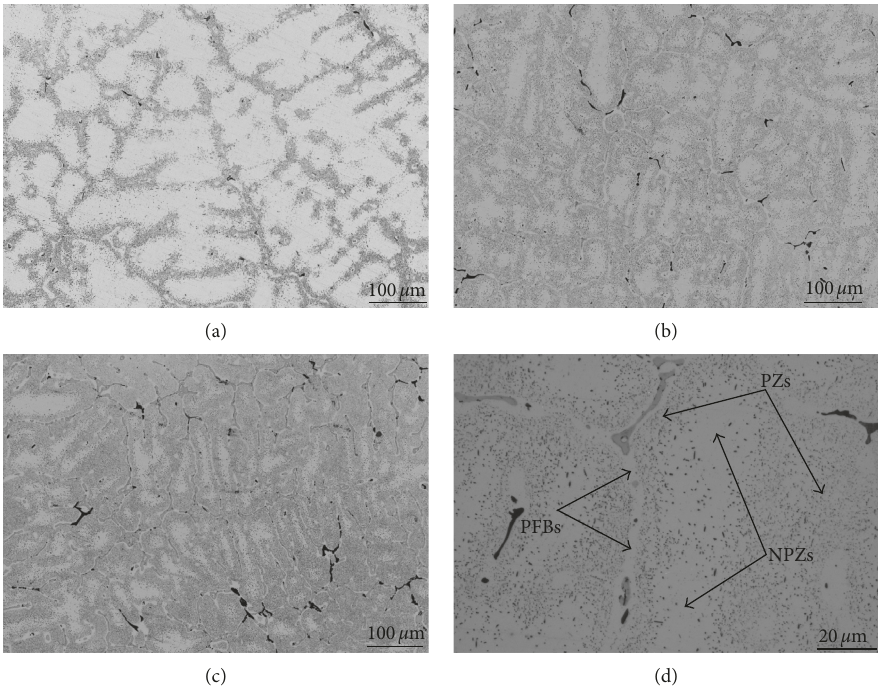
Figure 1: Optical microstructure of the studied alloys as-solutionized, showing PZs (precipitation zones), NPZs (no precipitation zones), and PFBs (precipitation-free bands): (a) A 1 alloy; (b) A 2 alloy; (c) A 3 alloy; (d) large magnification photo of the A 2 alloy.